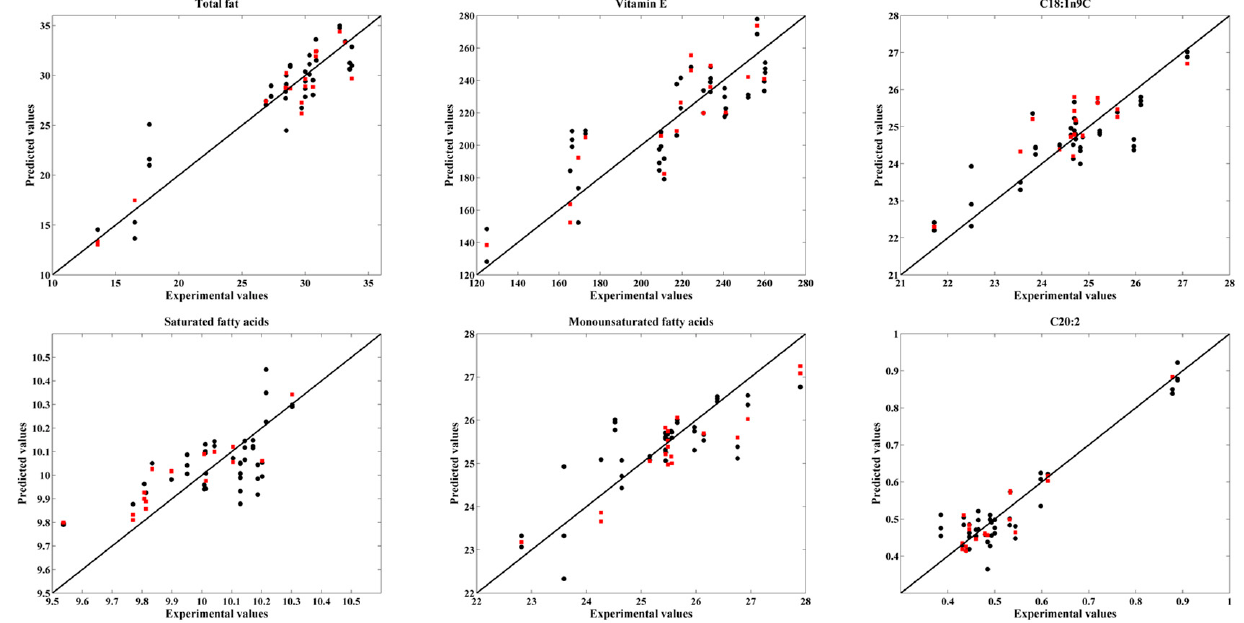
Figure 4. Experimental values versus the cross-validation ( ● ) and validation ( ) values obtained for total fat, vitamin E, C18:1n9c, saturated fatty acids, monounsaturated fatty acids and C20:2.